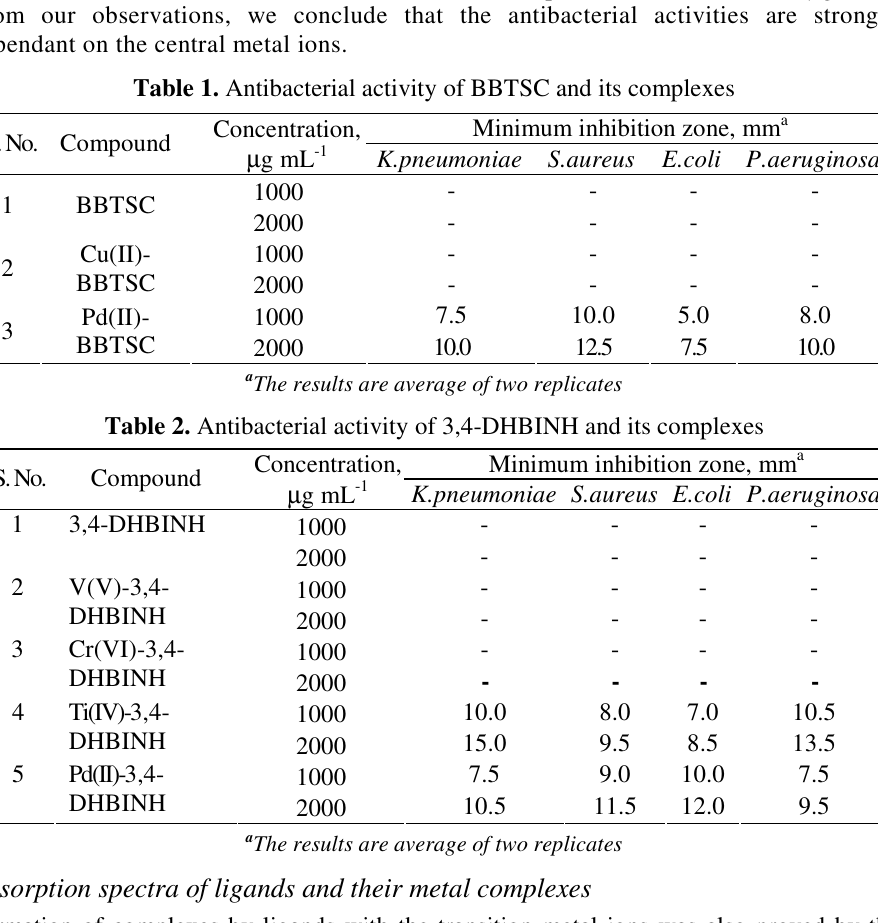
Table 1. Antibacterial activity of BBTSC and its complexes